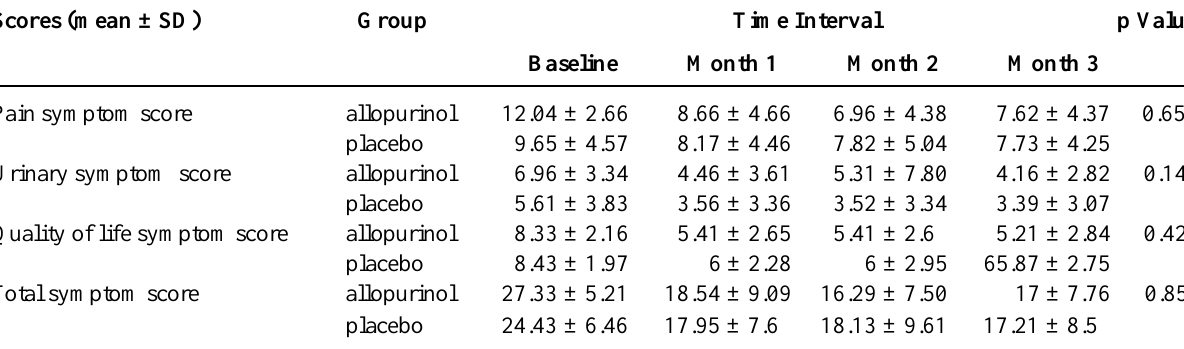
Table 2 – Mean and standard deviation of symptom scores in the 2 study groups.